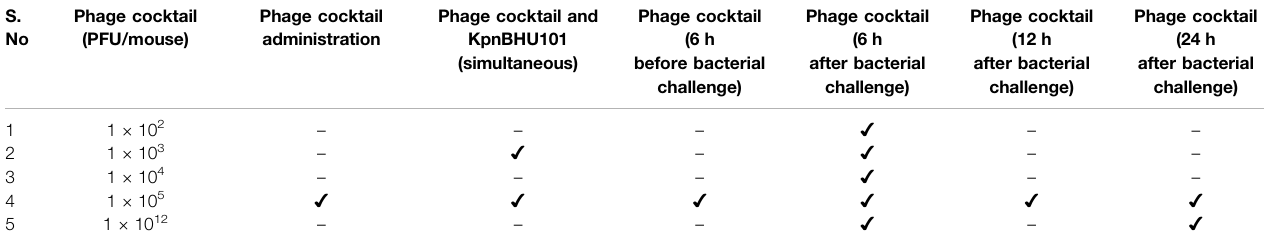
The symbol ( ✔ ) represents phage and bacterial challenge